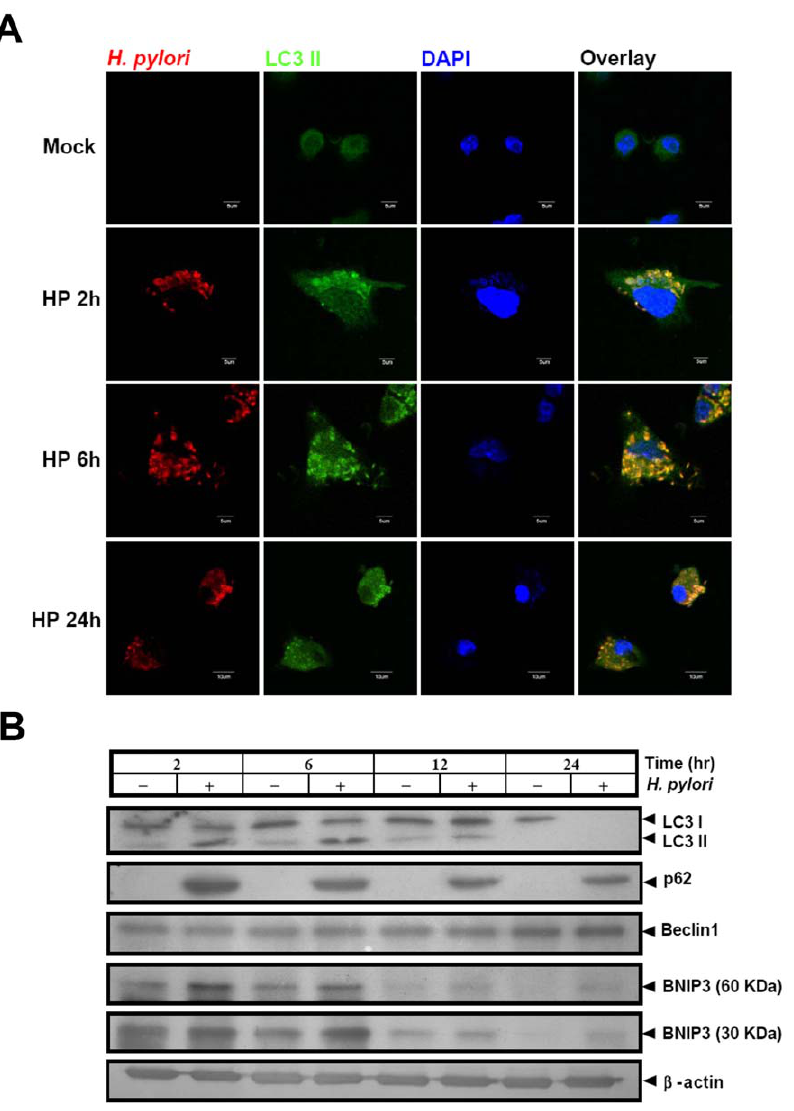
Figure 2. H.pylori infection in BMDCs induces autophagy. (A) BMDCs were infected with HP238 at m.o.i.=10. At 2, 6, and 24 h post infection, the infected cells were stained with anti- H. pylori antibodies (red) and LC3-II antibodies (green). (B) LC3-II conversion and autophagic flux in H. pylori - infected BMDCs. BMDCs were infected with H. pylori at m.o.i.=10 for 2, 6, 12 or 24 h post infection, protein samples were collected for LC3-II, p62, Beclin1, BNIP3 and b -actin analysis by Western